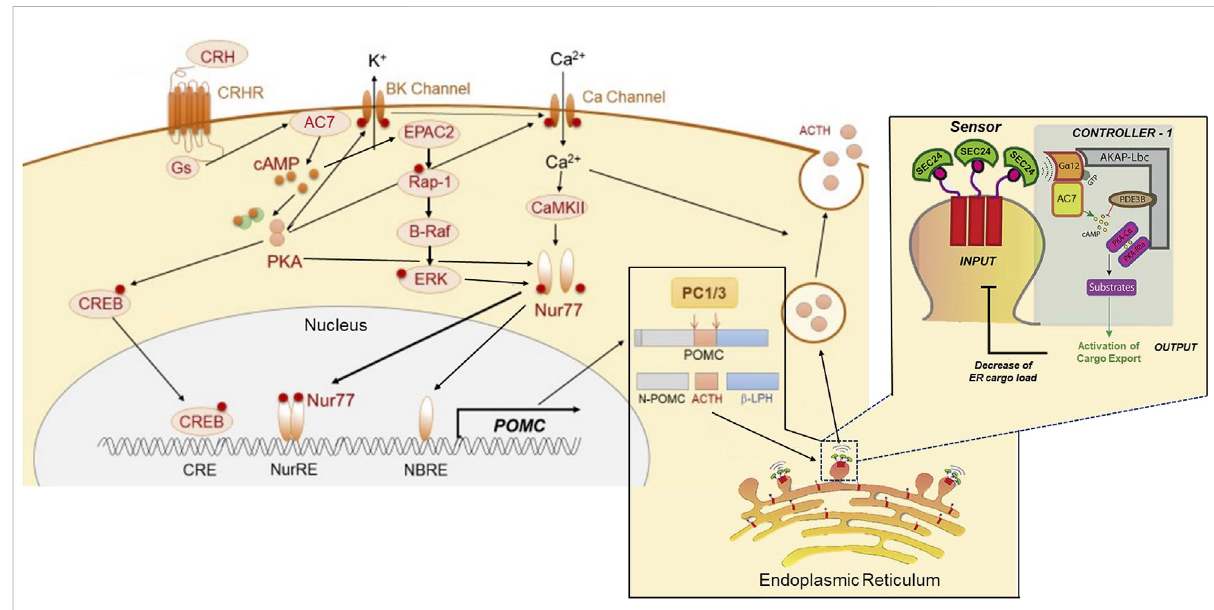
FIGURE 3 Proposed dual sitesof action of AC7in peptide (ACTH) synthesis and release. AC7 can participate in both thecontrol of synthesis and release of ACTH. CRF (CRH) activates AC7 through a Gs-coupled mechanism and increases production of cAMP. The cAMP enhances the active state of both PKA and Epac2. PKA acts through its canonical CREB transcription activator pathway by phosphorylating CREB and translocating it to the nucleus to bind to its DNA promoter sequence. The binding of CREB to DNA is necessary but not suf fi cient to activate the transcription of POMC (the precursortoACTH).TheactivationandDNAbindingofNur77isarequirementforinitiationoftranscription.Thephosphorylationandtranslocationof Nur77 to the nucleus, requires a coordinated interaction of ERK, PKA and CAMKII (Kovalovsky et al., 2002; Zhang and Heaney, 2020). Two sites for Nur77-binding exist upstream of the POMC transcription initiation site, a Nur77-binding response element (NBRE), and a Nur response element (NurRE), and both need to be occupied by Nur77 to initiate the transcription of POMC. Once the POMC RNA is produced, it is translocated to the endoplasmicreticulum forproteinsynthesis, and theprocessing ofthepre-propeptide(POMC) byproproteinconvertase (PC1/3)intoACTH andthe other POMC derived peptides. The ACTH has to be loaded into dense core vesicles which are generated by “ budding ” ofthe endoplasmic reticulum, and the “ cargo ” of these vesicles(ACTH) is then readied for release bya calcium-dependent mechanism through fusion with thecellular membrane. AC7 is integral in the process of loading and preparing vesicles for release. AC7 is located on the endoplasmic reticulum membrane where it can be activated by G α q12. The activation of Gq12 by guanine nucleotide exchange is instigated by a sensor on the budding vesicle, SEC24. The cAMP producedbyAC7atthissitecanactivatePKA(whichisrecruitedtothissitebyanAKAP).PKA-dependentphosphorylationofanill-de fi nedsubstrateis then central to the process of release of the concentrated cargo by controlling the uncoating and separation of the maturing vesicles from the endoplasmic reticulum. This Figure was generated based on illustrations and information provided by Fukuoka et al. (2020), and Subramanian et al.